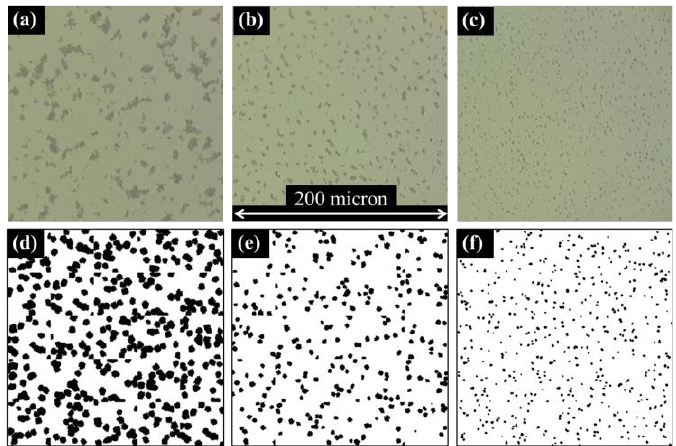
Figure 3. Microscopy images at 100 × magnification of spin-coated films with average thicknesses of ( a ) 6 μm, ( b ) 4 μm, and ( c ) 2 μm; ( d – f ) simulated film RVEs of matching thickness and cross-sectional area to their experimental counterparts above.